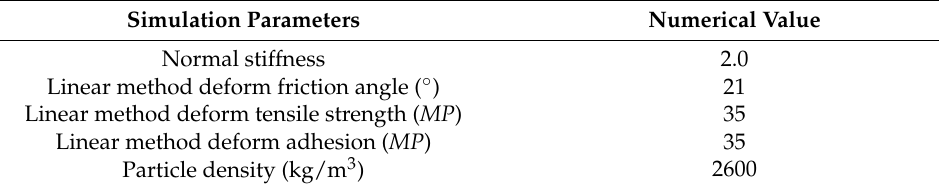
Table 3. Medium weathered calcareous sandstone.